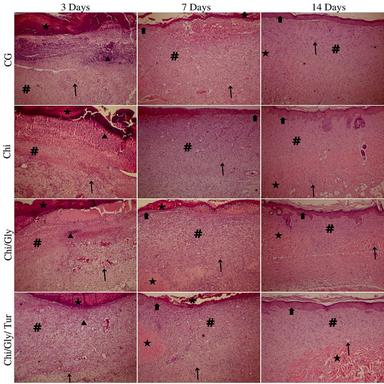
Photomicrographs representing the experimental groups related to inflammatory infiltrate, collagen expression and wound re-epithelialization. Legend: = crust; # = granulation tissue; ▴ = inflammatory infiltrate; = blood vessels; = re-epitheliazation; = collagen fibers.